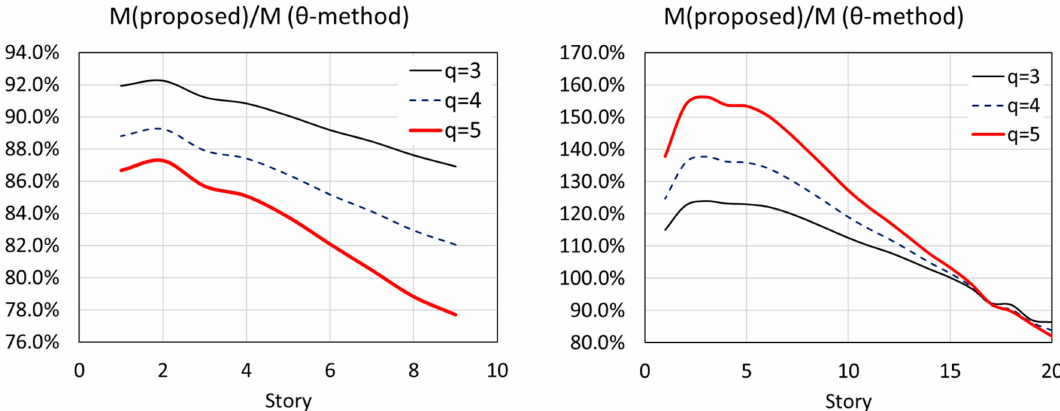
Figure 12. The di ff erence between the proposed method and the stability factor method in estimating the design resisting